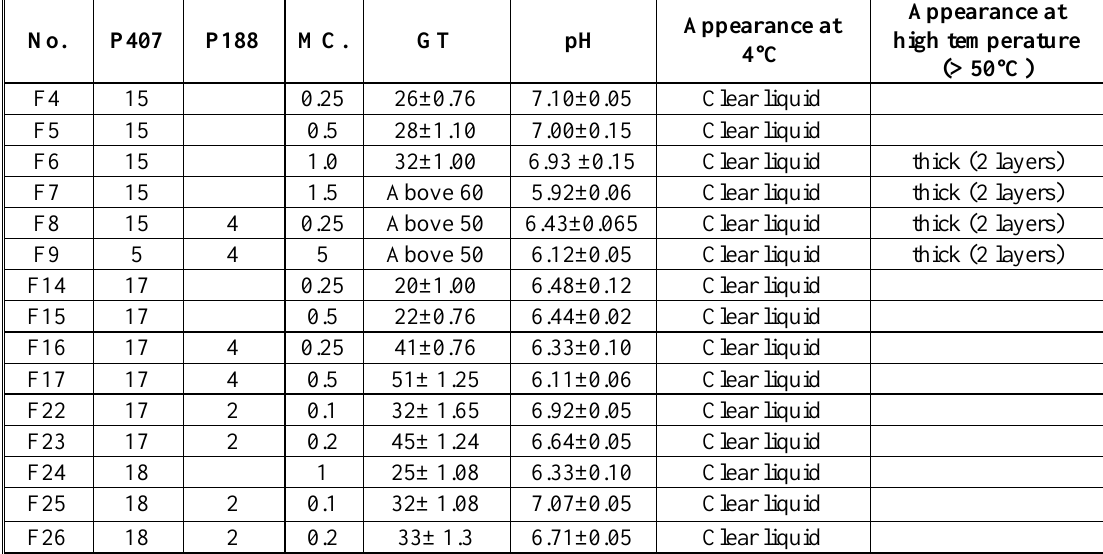
Table 2 .B Gelation temperature GT, appearance, pH of the formulated SC periodontal in-situ gel with MC as mucoadhesive